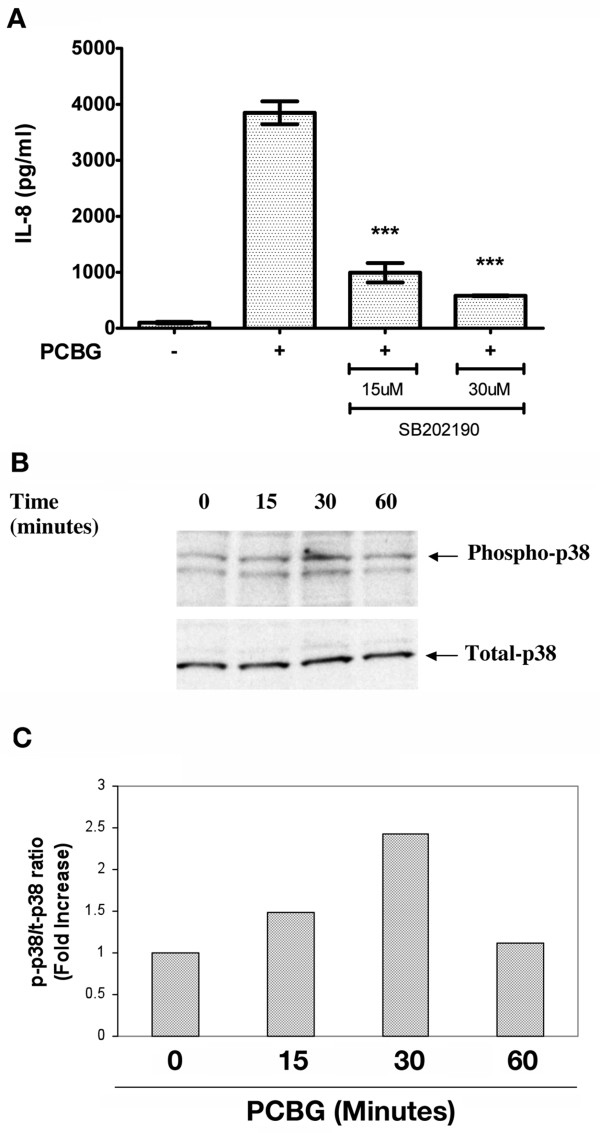
Activation of p38 MAPK after PCBG stimulation of 1HAEo-cells. A. 1HAEo- cells were incubated with 100 μg/ml of PCBG for a period of eight hours, and the media supernatants collected and IL-8 measured by ELISA. Prior to the addition of PCBG the cells were pretreated for 1 hour with the p38 inhibitor SB202190. Data were analyzed with one-way ANOVA and posttest Bonferroni comparison (***denotes p < 0.001). B. 1HAEo- cells were challenged with 100 μg/ml of PCBG for the times indicated and phospho-p38 and total p38 analyzed by western blot in the total cell lysates. C. Densitometry analysis of phospho-p38 to total p38 ratio. The data shown is representative of three independent experiments.